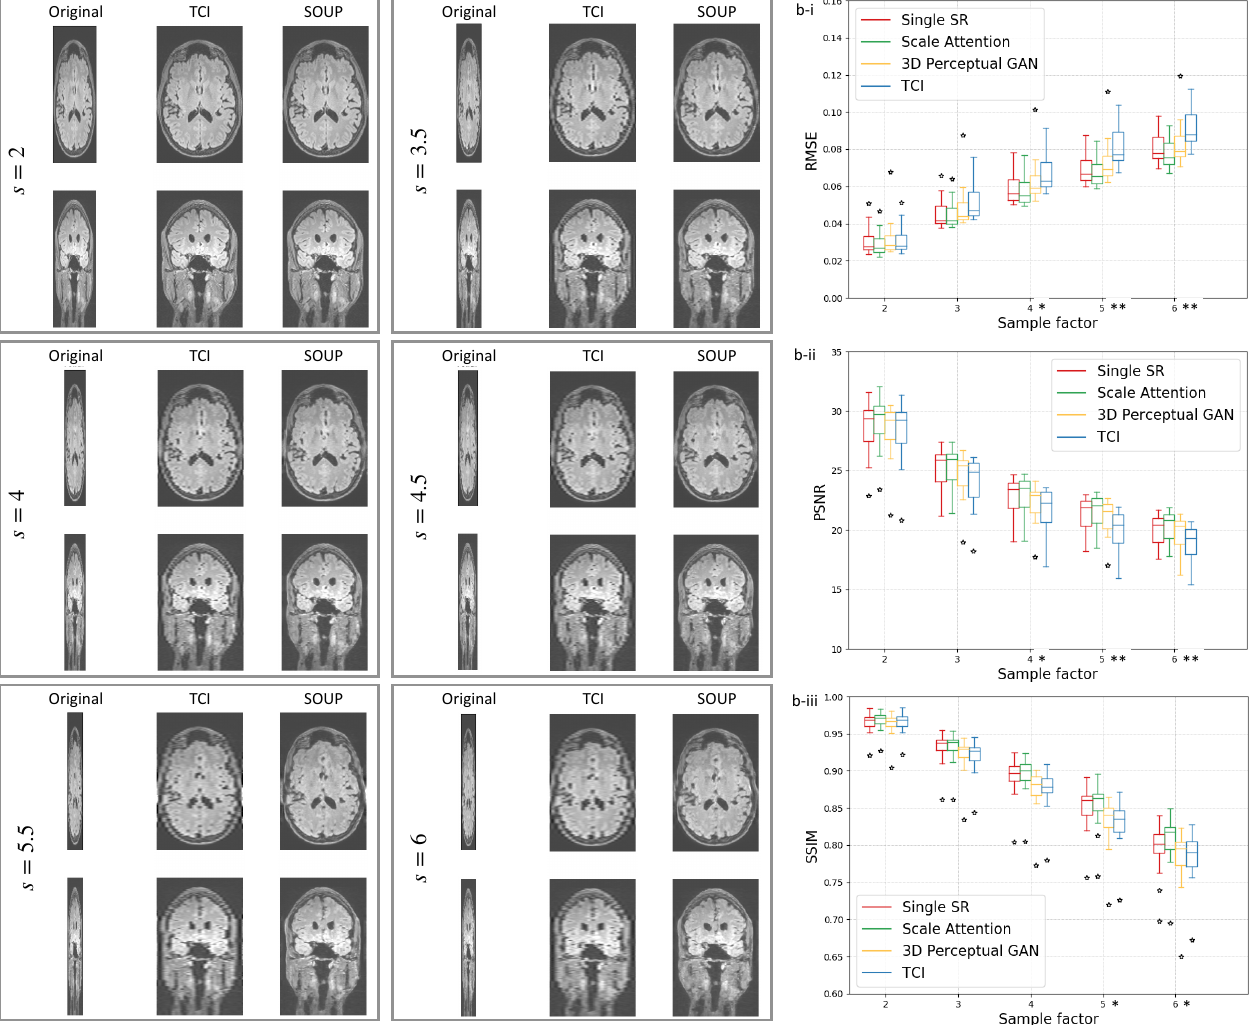
Figure 5. ( a ) Comparison between scale-attention model and cubic interpolation on T2-FLAIR brain MRI at different scales. ( b ) Evaluation using T2-weighted brain MRI images with quantitative comparisons of measures: ( b-i ) RMSE, ( b-ii ) PSNR, and ( b-iii ) SSIM in terms of the sampling factor s. DeepResolve proposed in [32] is similar to the single SR (in red). Statistical significance is indicated on the x-axes with * for p < 0.05 and ** for p < 0.001. TCI: tricubic interpolation; GT: ground